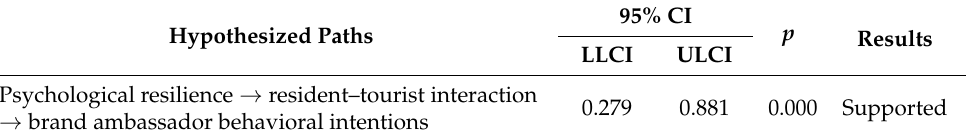
Table 3. Mediating effect.